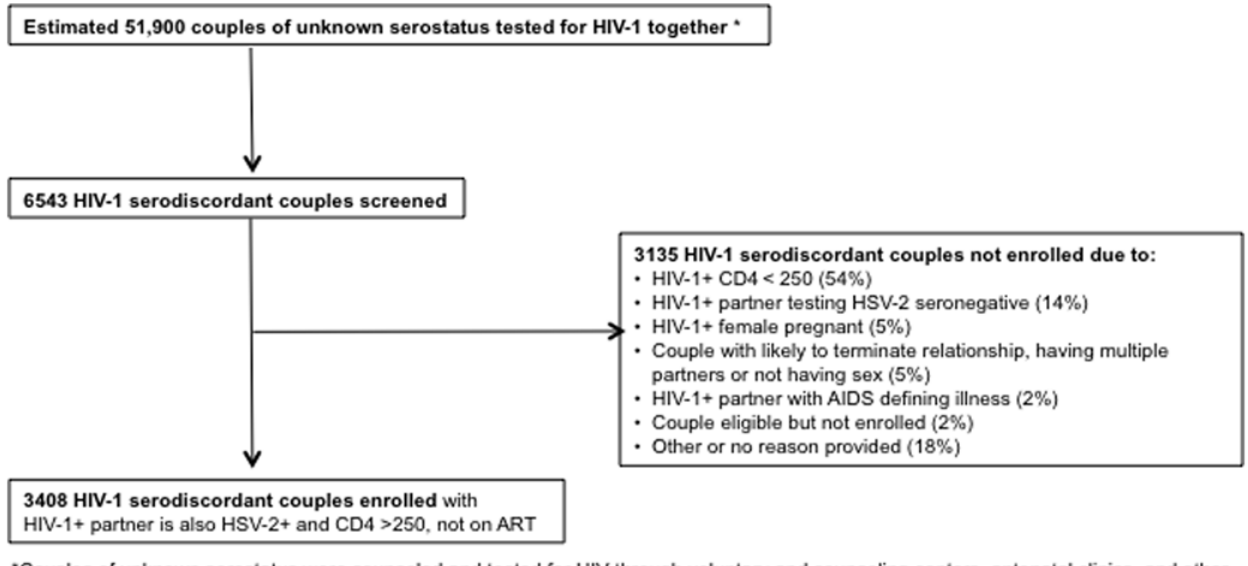
Figure 1. Prescreening, Screening and Enrollment Flow for HIV-1 serodiscordant couples in the Partners Study.